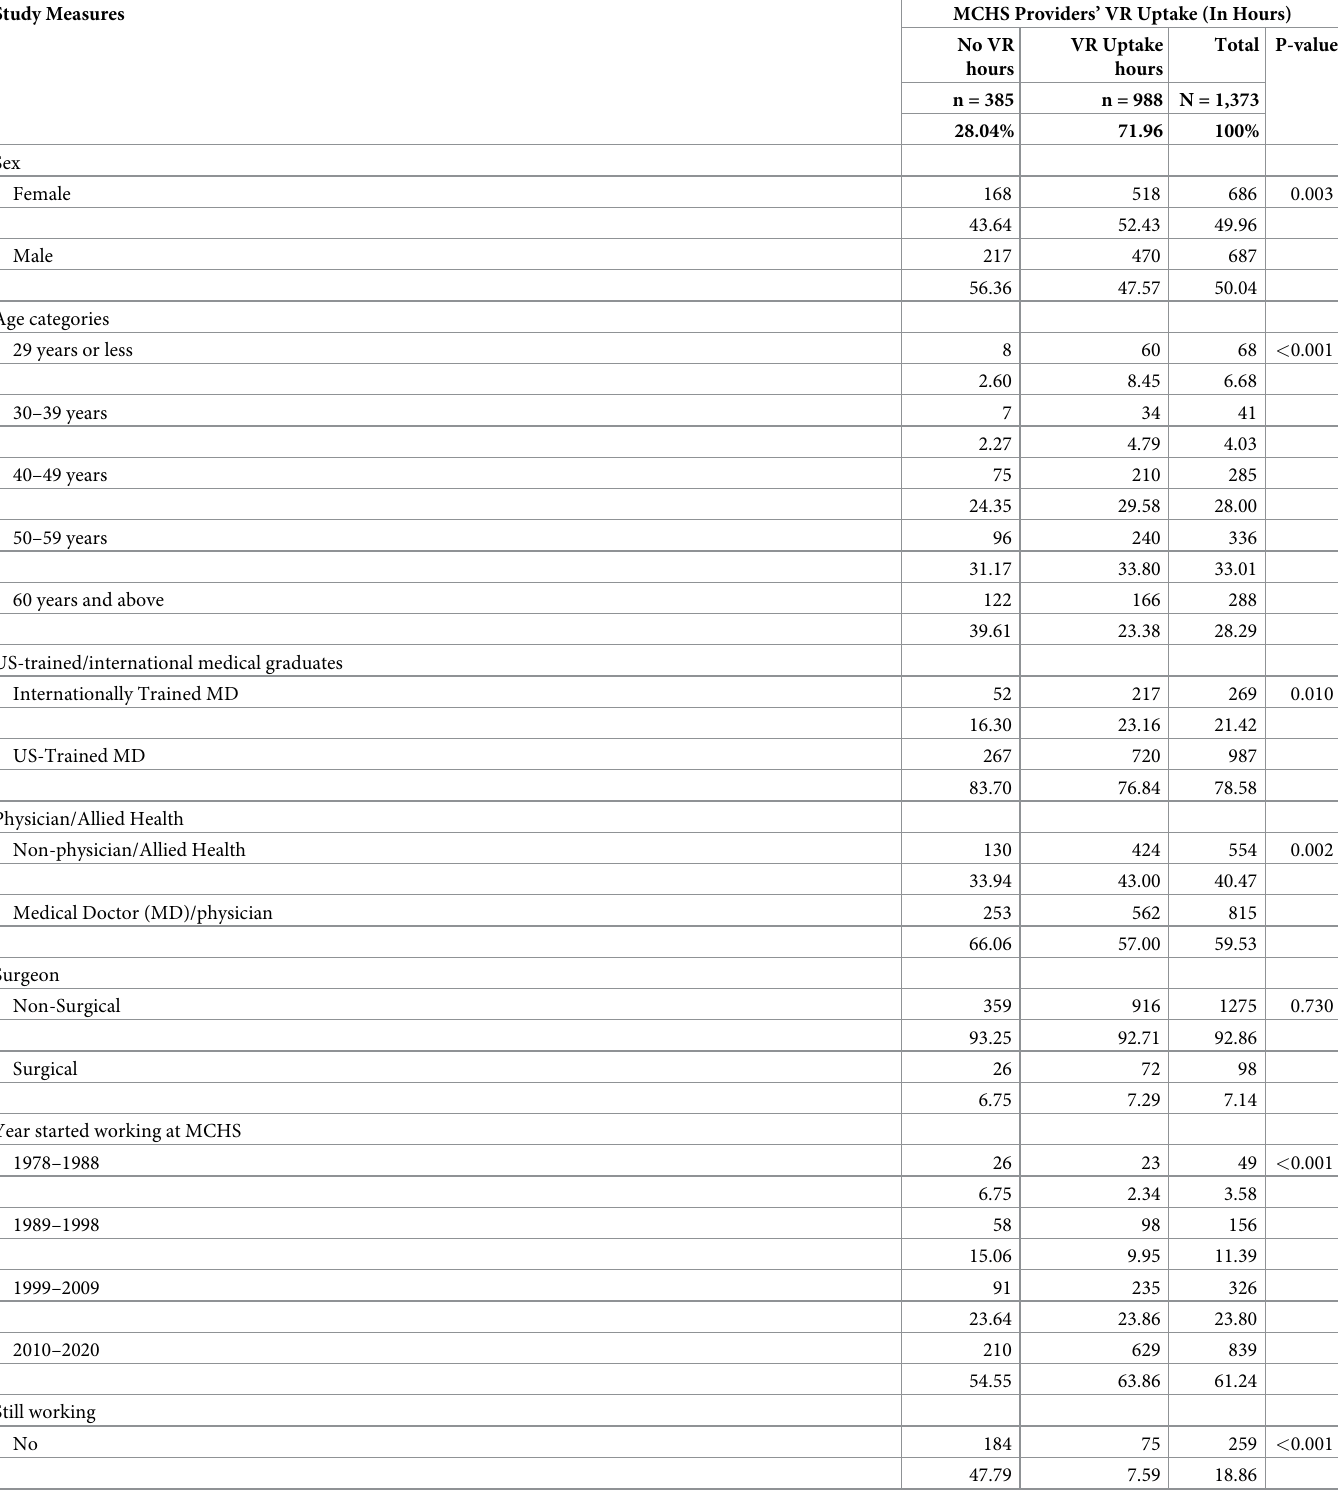
Table 2. MCHS providers’ voice recognition uptake by user and institutional characteristics,